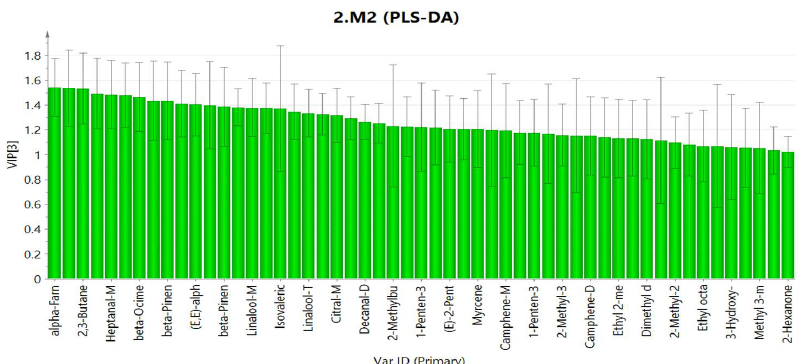
Figure 7. PLS−DA analysis of volatile compounds in Qu Aurantii Fructus, Aurantii Fructus and